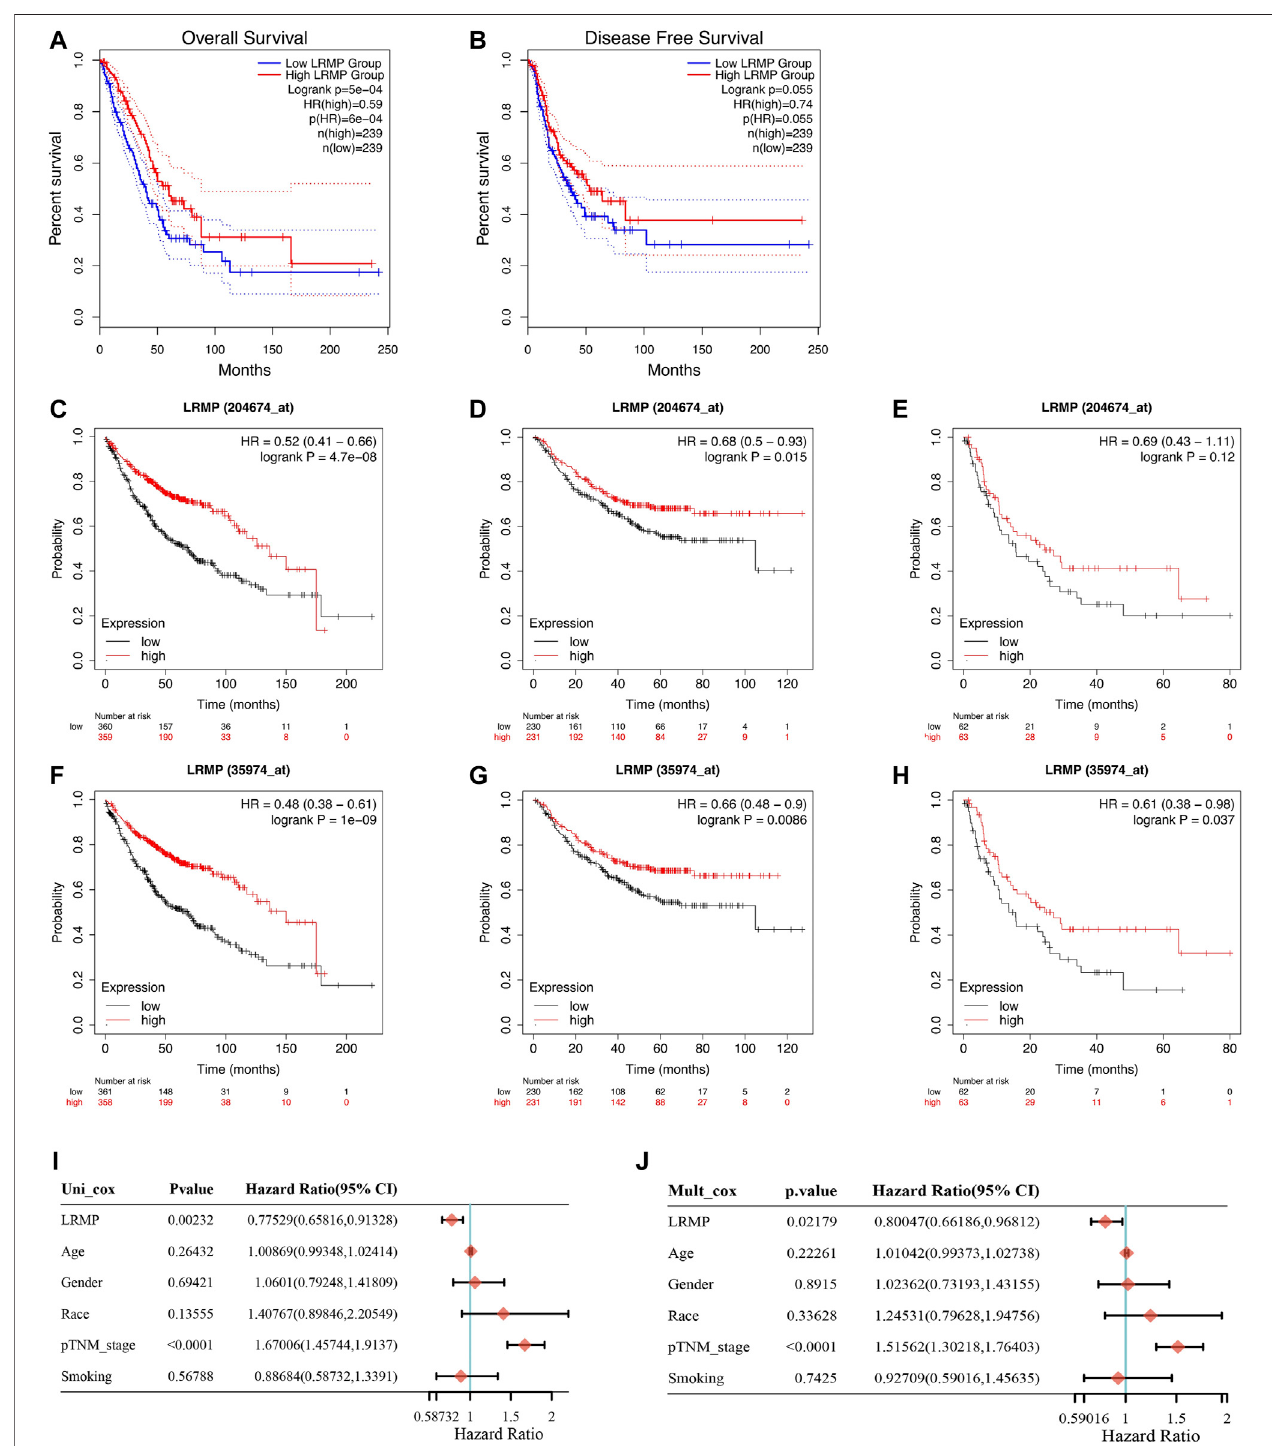
FIGURE 3 | The prognostic value of lymphoid-restricted membrane protein (LRMP) in patients with lung adenocarcinoma (LUAD). (A – B) Overall survival and disease-freesurvivalofpatients withLRMP high andLRMP low LUADanalyzedinGEPIA2. (C – E) Overallsurvival,progression-freesurvival,andpost-progressionsurvival of patients with LUAD in Kaplan-Meier database with Affy ID: 204674_at based on LRMP expression levels. (F – H) Overall survival, progression-free survival, and post- progression survival of patients with LUAD in Kaplan-Meier database with Affy ID: 35974_atbased on LRMP expression levels. (I – J) Cox analysis showing the hazard ratios (HRs) of different